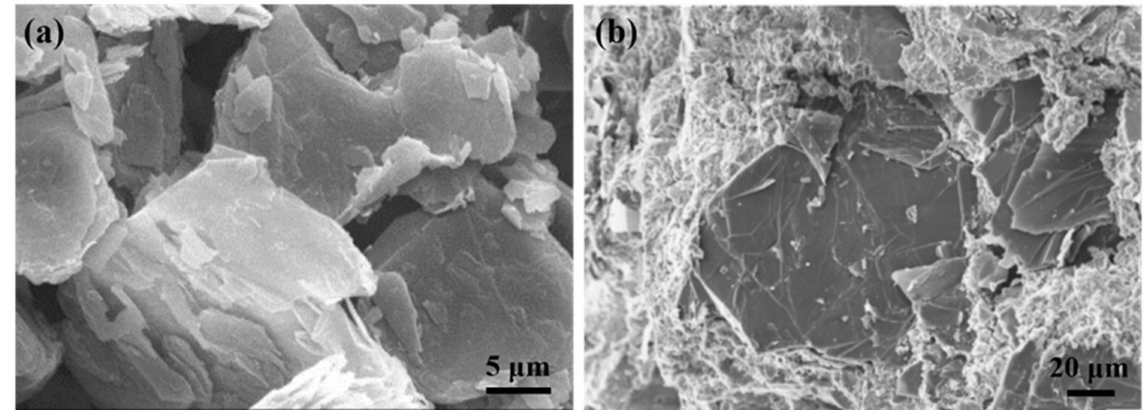
Figure 8. SEM micrographs of ( a ) pure graphite (reprinted (adapted) with permission from [71] ©2012 with permission from Elsevier) and ( b ) graphite-cement paste after five months (reprinted (adapted) from [3] which is an open access article and permits unrestricted